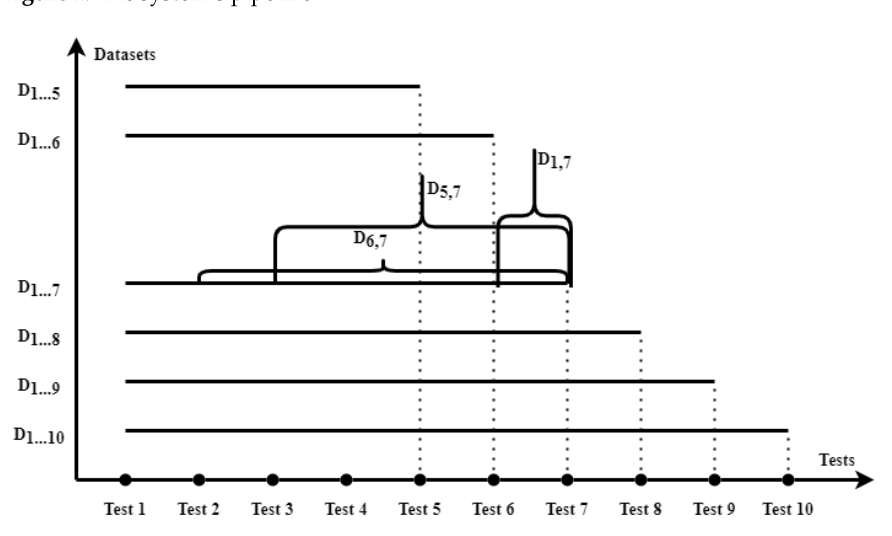
Figure 1. The system’s pipeline.